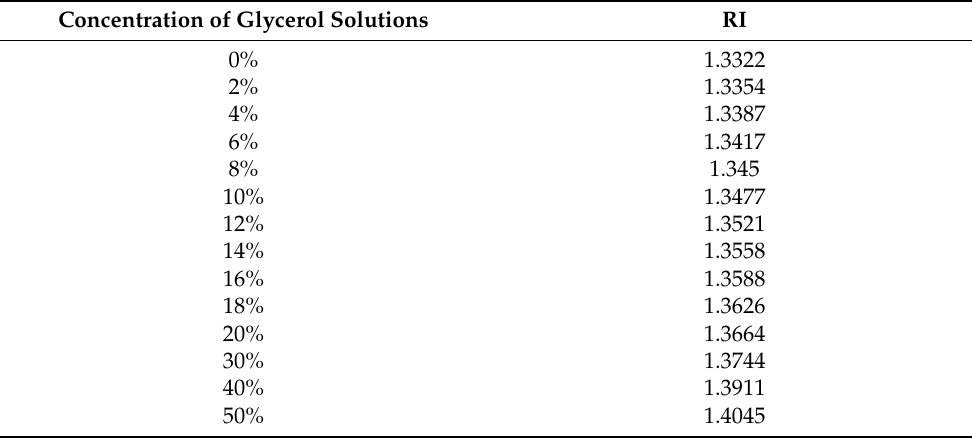
Table 1. The concentration of test solutions and corresponding values of RI. Concentration of Glycerol